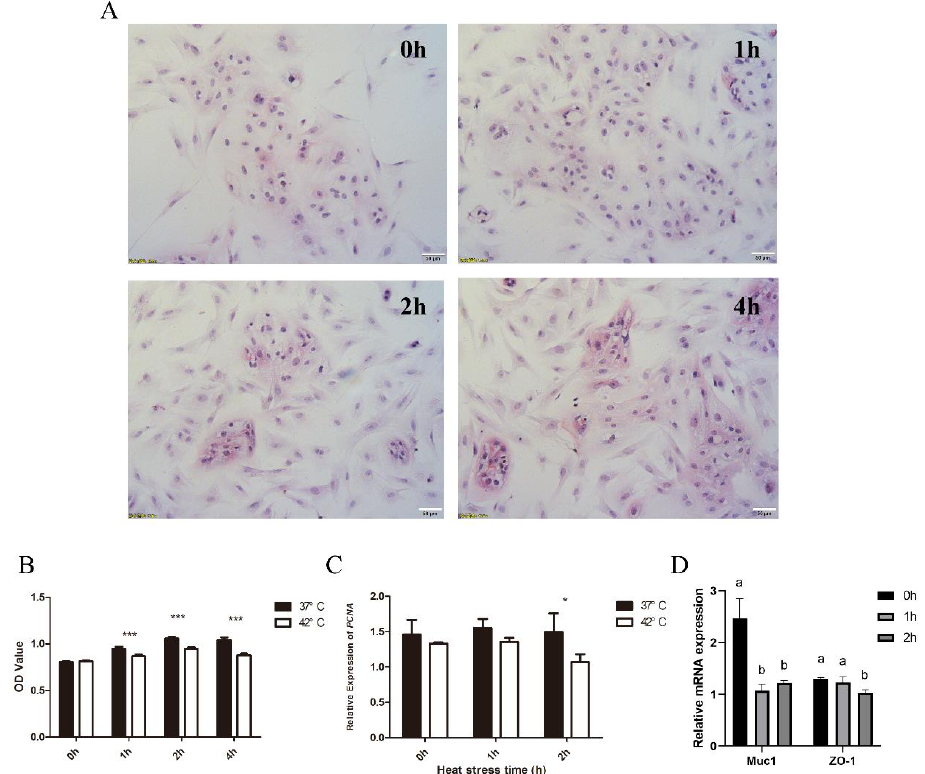
Figure 7. Impact of heat stress on porcine endometrial epithelial cells. ( A ) Morphological changes of EECs after heat stress. ( B ) Viability of EECs under HS. ( C ) Impact of HS on expression level of genes associated with cell proliferation (PCNA). ( D ) Impact of HS on expression level of genes associated with embryo implantation and cell adhesion ( MUC1 and ZO-1 ). *, p < 0.05 and ***, p < 0.001. ab means in the same bar without a common letter differ at p < 0.05.